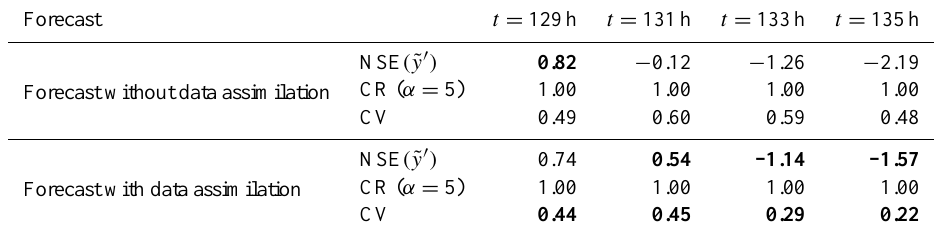
Table 3. Results of the validation measures for the April 2003 flood event. Forecast